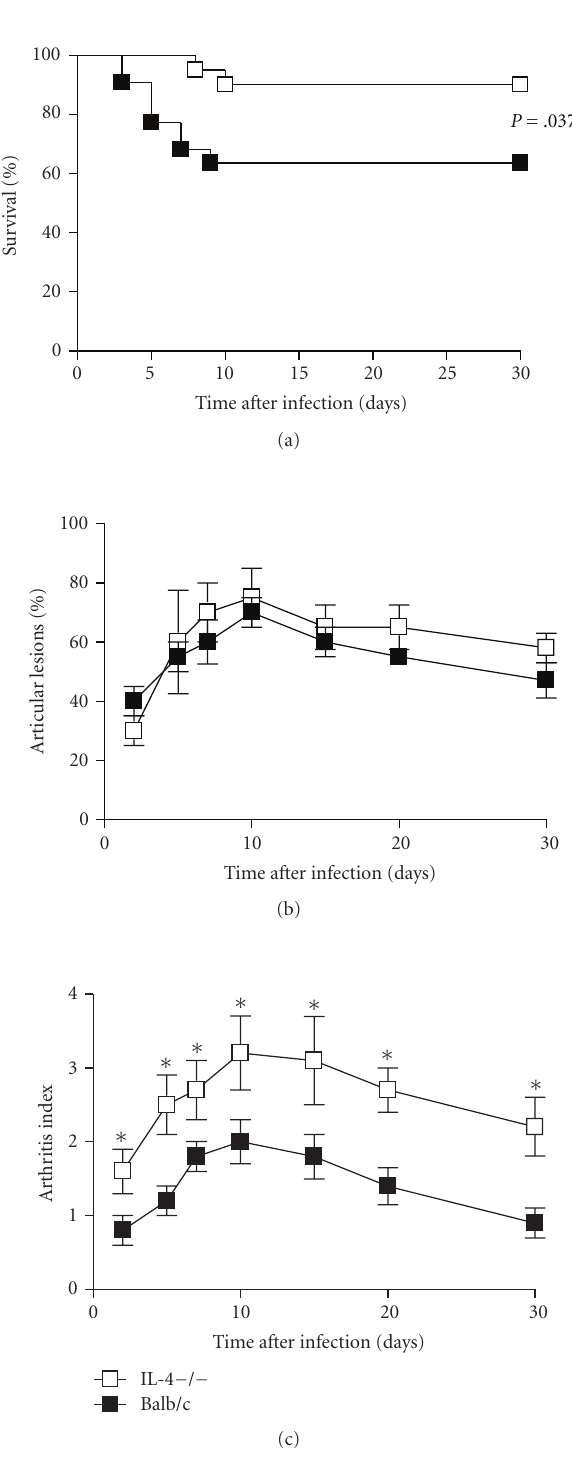
Figure 1: Mortality rates, incidence, and severity of arthritis. IL-4- deficient and wt mice were infected with 10 7 GBS/mouse. Mortality (a), incidence (b), and severity (c) of arthritis were evaluated as detailed in materials and methods (see Section 2). Ten mice were used in each experimental group. (a) The data are the cumulative results of three separate experiments. (b) and (c) Data represent the mean ± SD of three separate experiments. Statistical di ff erences between the experimental groups were marked with asterisk ( P < .